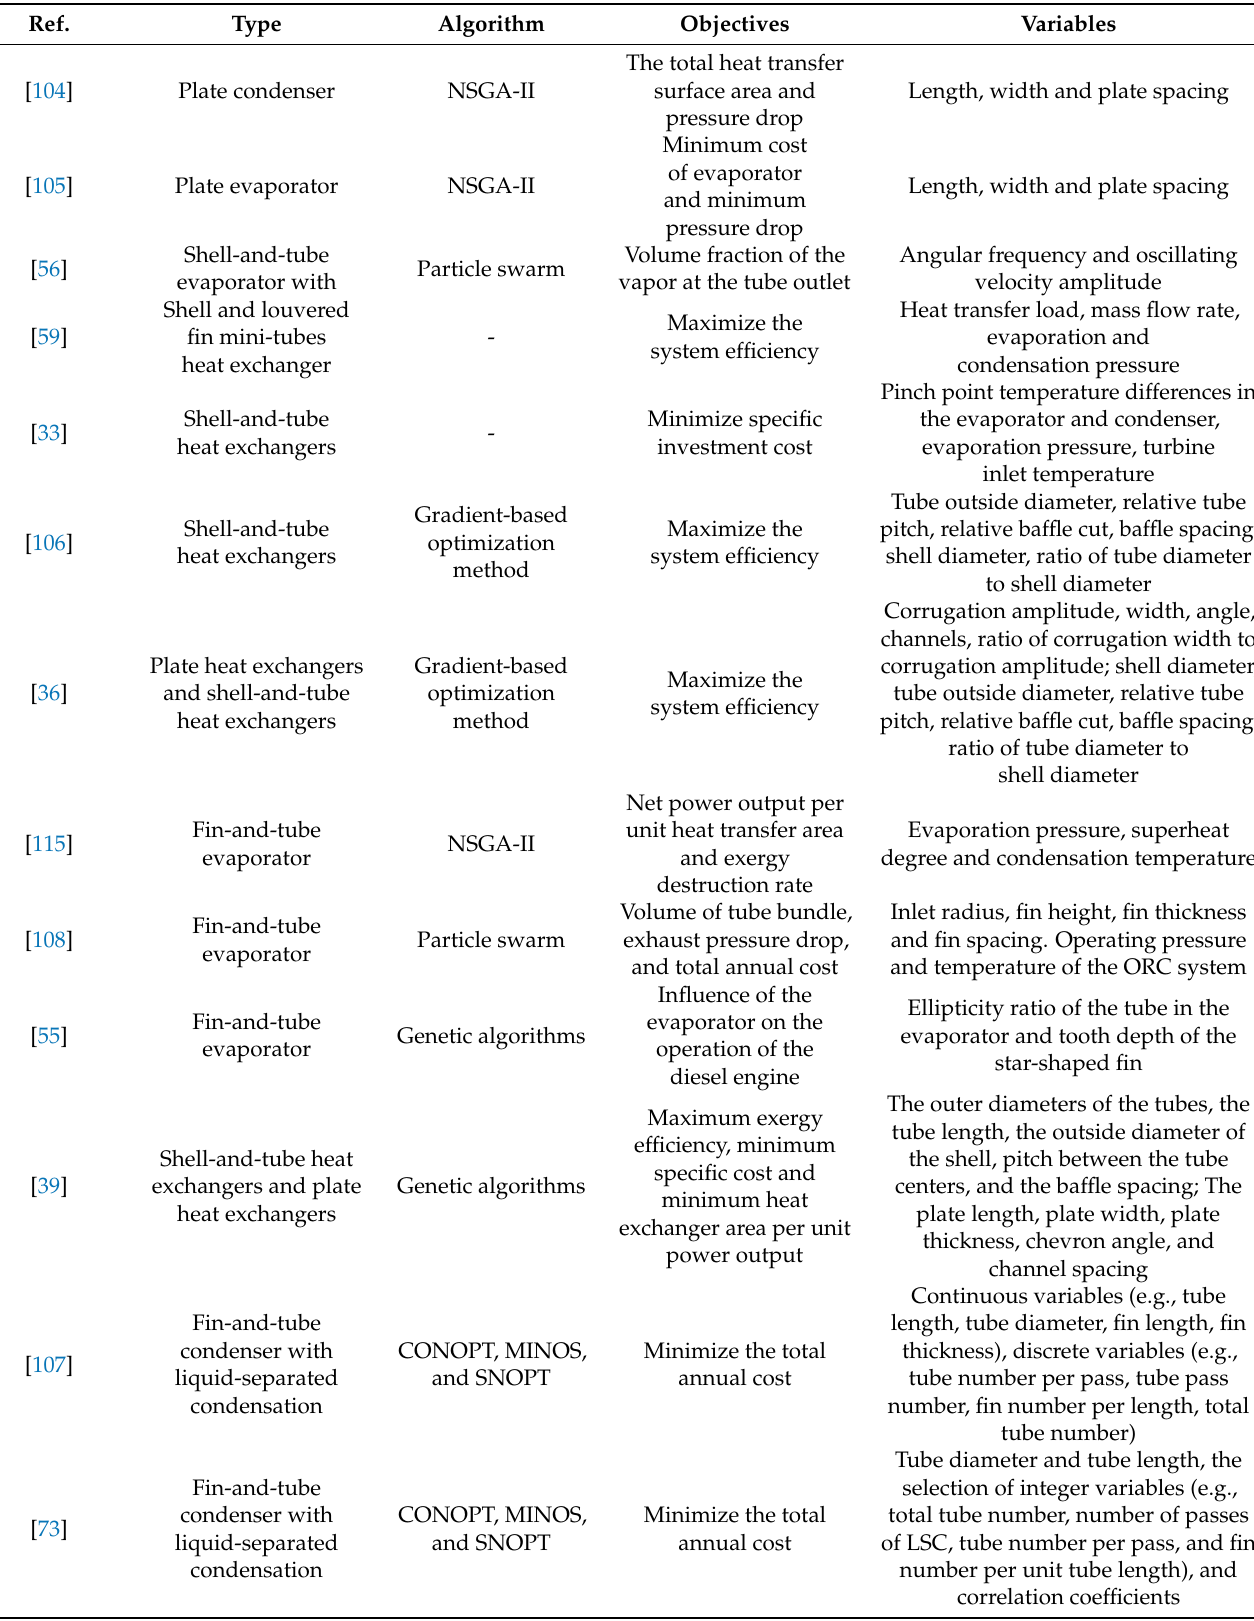
Table 4. Summary and comparison of the heat exchanger optimization in ORC.